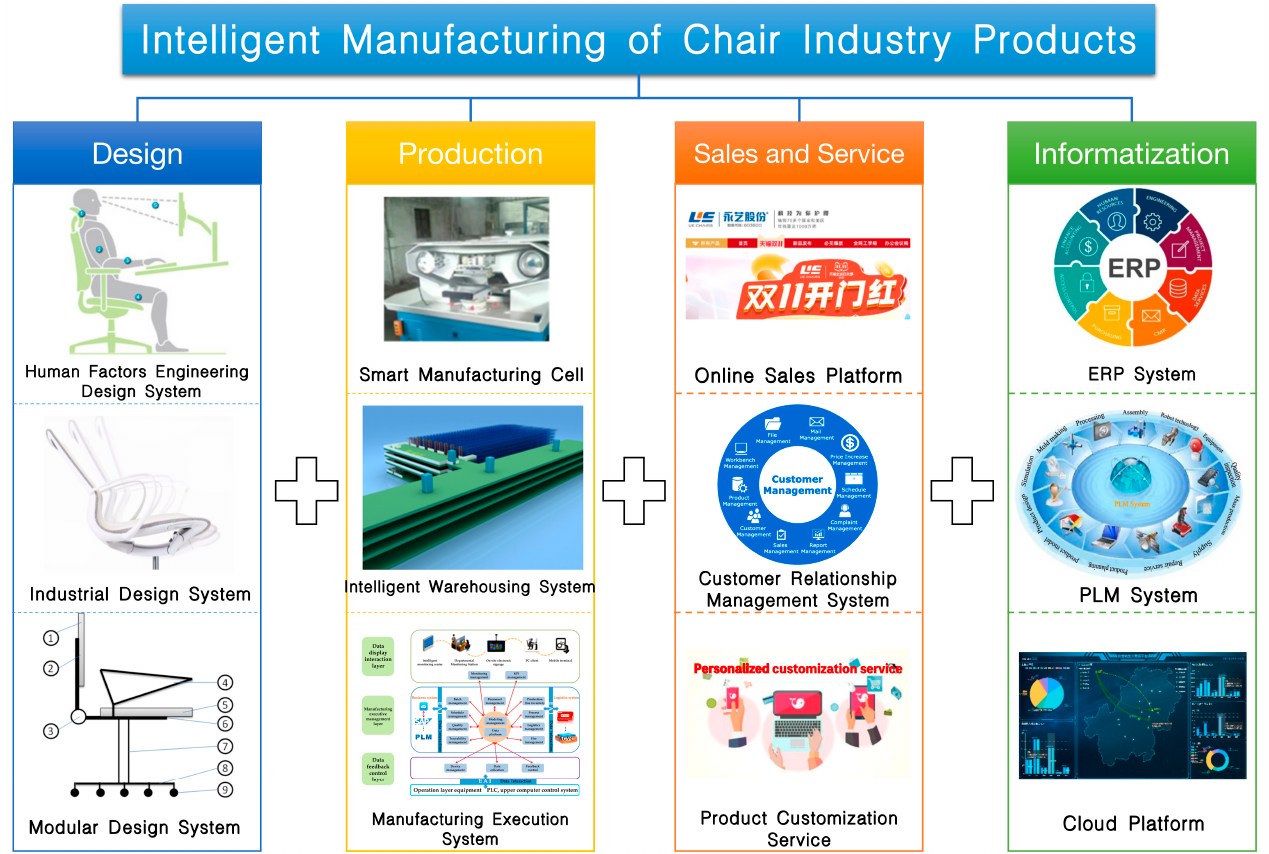
Figure 2. Application of intelligent manufacturing technology in the chair